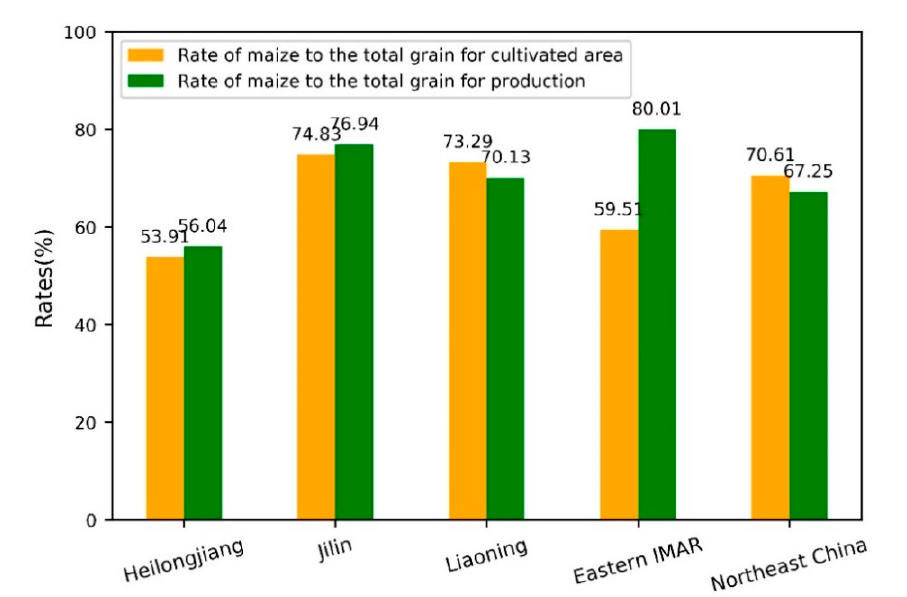
Figure 2. Rate of maize to the total grain for cultivated area and production in 2015.